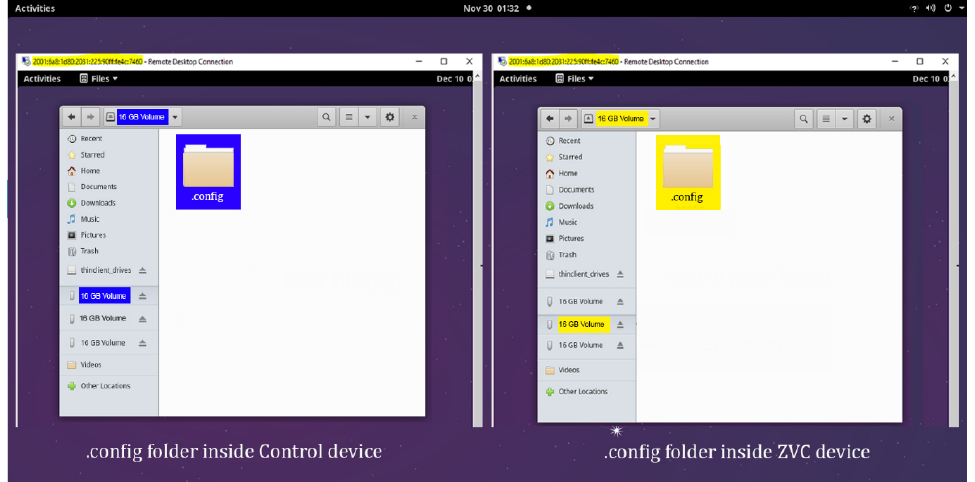
Figure 12. The private key stored in the .config folder in the control (blue) as well as the ZVC (yellow) device .